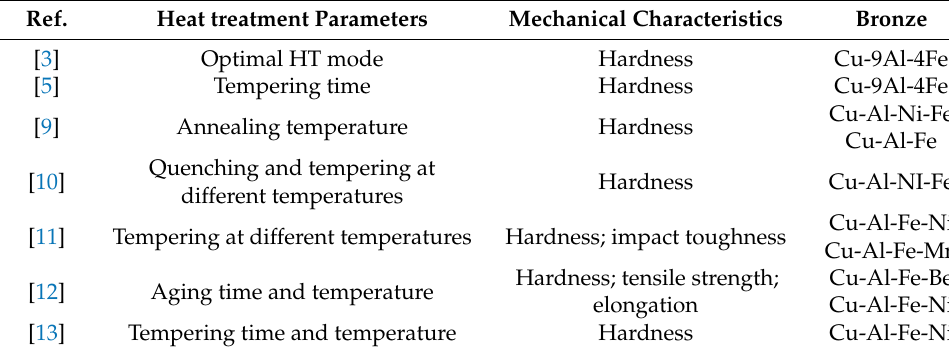
Table 1. Effect of heat treatments on mechanical characteristics.